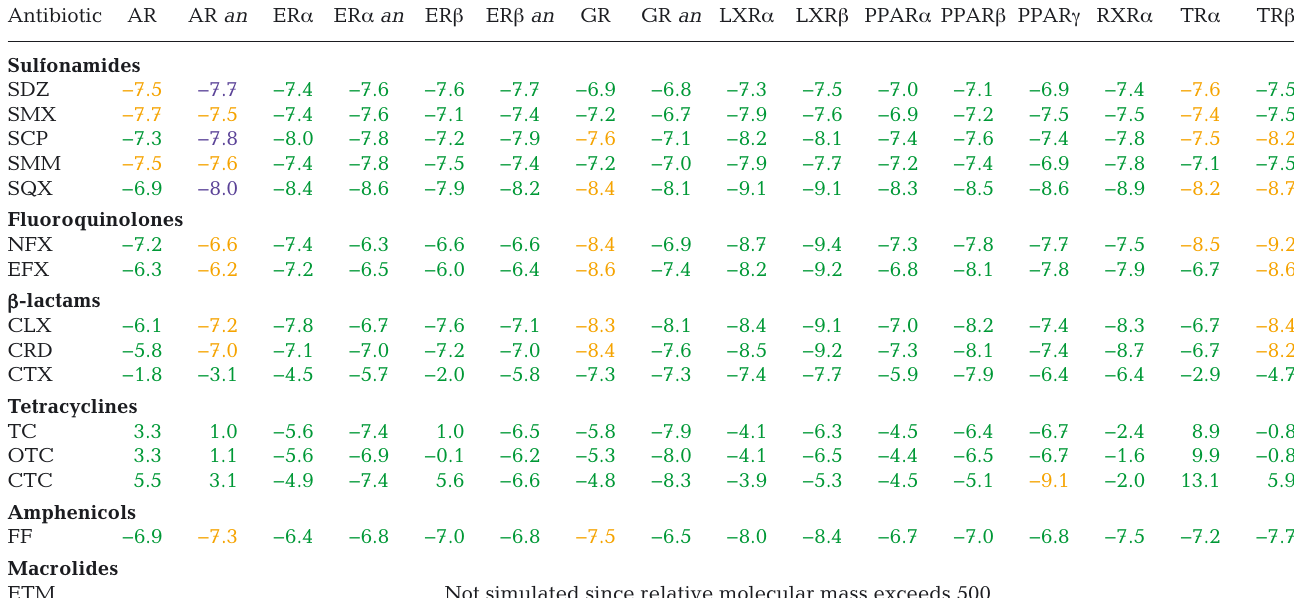
Table 2. Binding affinity scores of antibiotic molecules with 16 human nuclear hormone receptor conformations (12 agonistic and 4 antago- nistic [ an ] conformations) predicted by reverse docking. The more negative the value, the higher the score. Gradation of binding affinity scores was done based on the probability of binding. Probability binding classes are color-coded: purple: medium-high probability; yellow: medium probability; and green: low probability. AR: androgen receptor; ER α / β : estrogen receptors α and β ; GR: glucocorticoid receptor; LXR α / β : liver X receptors α and β ; PPAR α / β / γ : peroxisome proliferator-activated receptors α , β and γ ; RXR α : retinoid X receptor α ; TR α / β